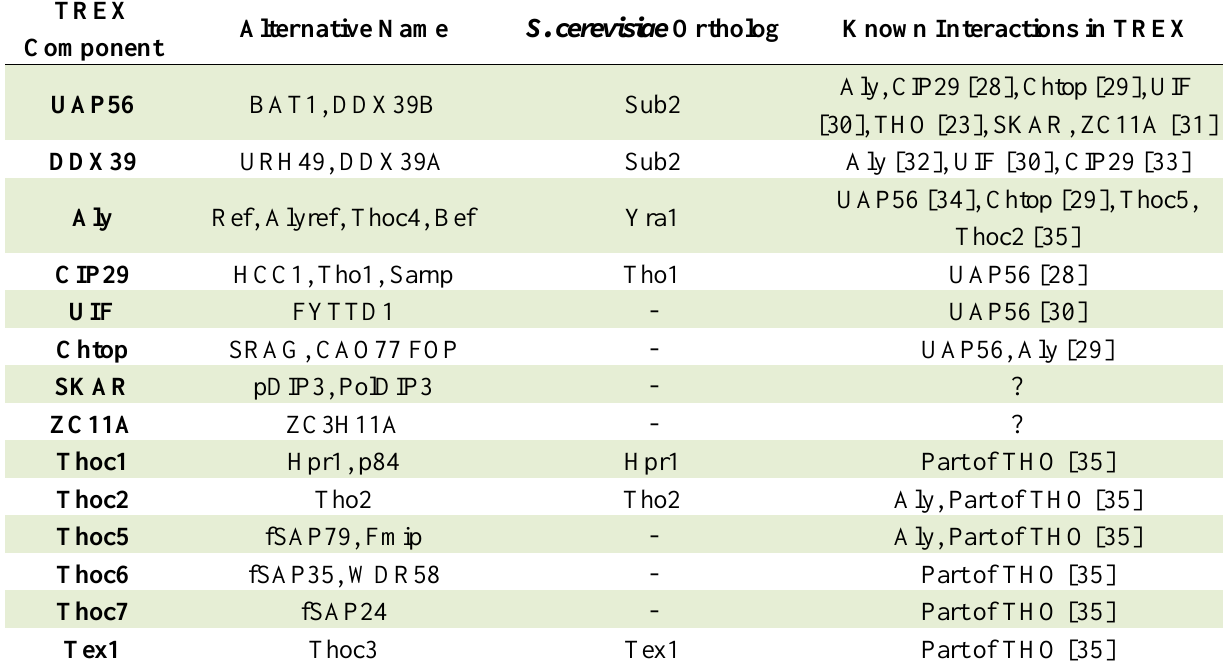
Table 1. Known components of the human transcription-coupled export (TREX)